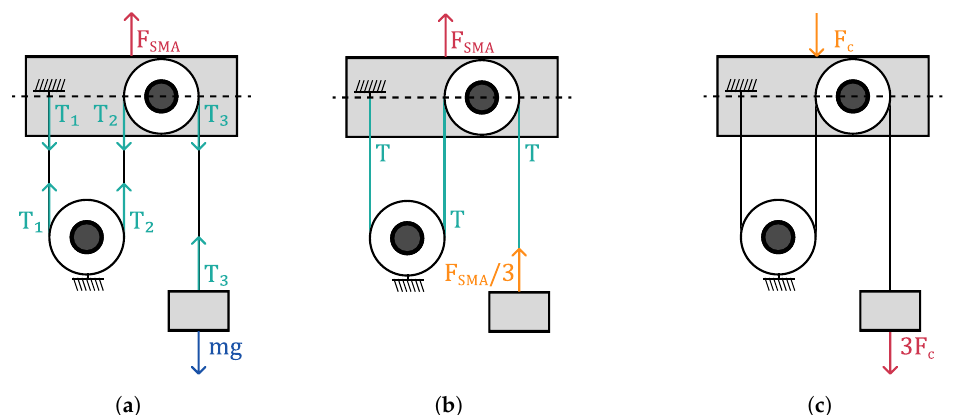
Figure 3. Mechanical advantage of the hoist. The force pulling the nylon thread through the hoist (red) is diminished at the other end of the thread, and a force divided by the MA (orange) is produced. ( a ) Dynamic analysis of the system. ( b ) Forces in the heating state. ( c ) Forces in the cooling state.